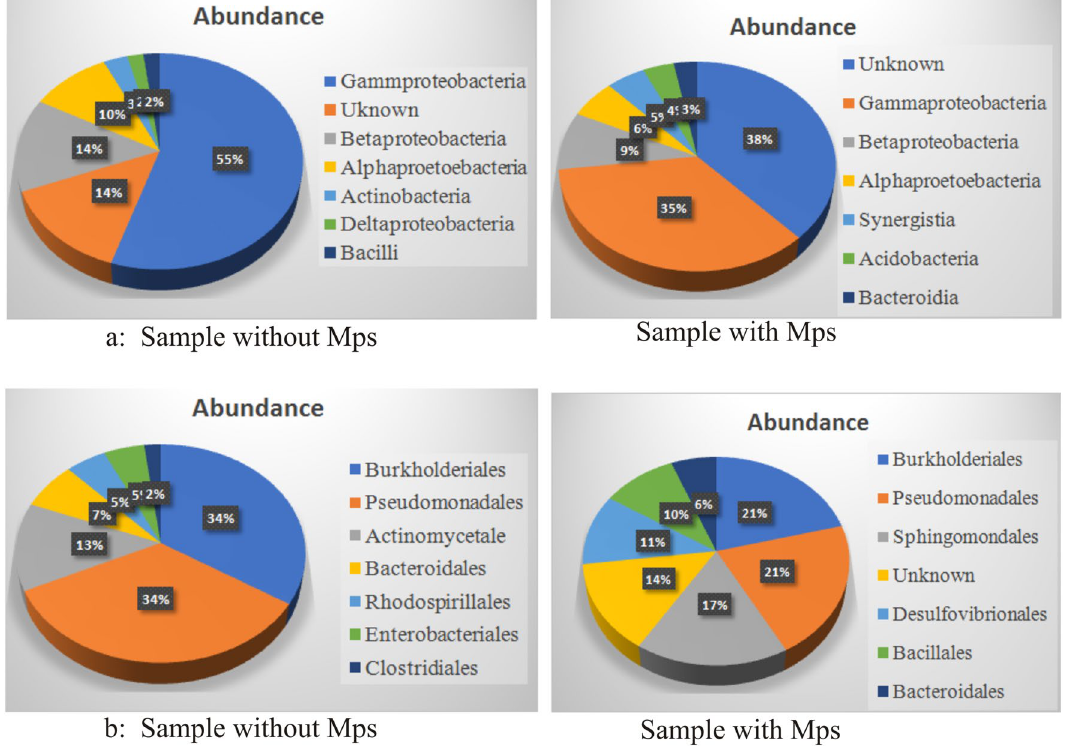
Fig. 2 a Top 7 Classes in both classes. b Top 7 Orders in both